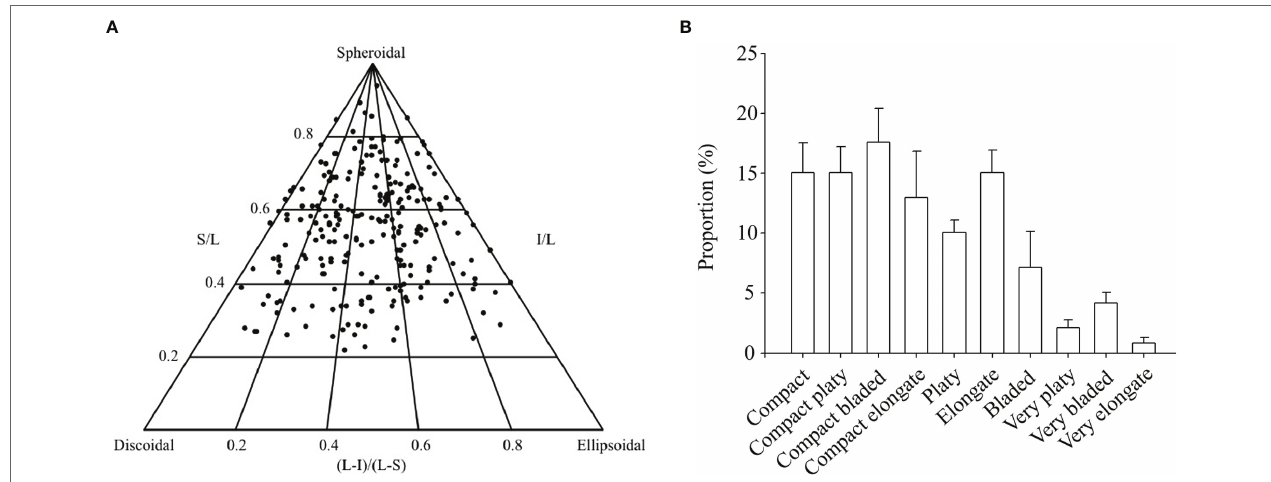
FIGURE 3 | (A) Ternary diagram of rhodolith [ Lithothamnion glaciale ] shape relative to purely spheroidal, discoidal, and ellipsoidal rhodoliths [N=247; one solid circle per rhodolith]. Rhodoliths were collected in April 2017 at the South site (see Figure 1A ). The position of each rhodolith in the diagram is determined by its sphericity, calculated from the length of its longest [L], intermediate [I], and shortest [S] axes. (B) Corresponding proportion of rhodoliths under each of 10 finer shape categories as defined by Sneed and Folk (1958).